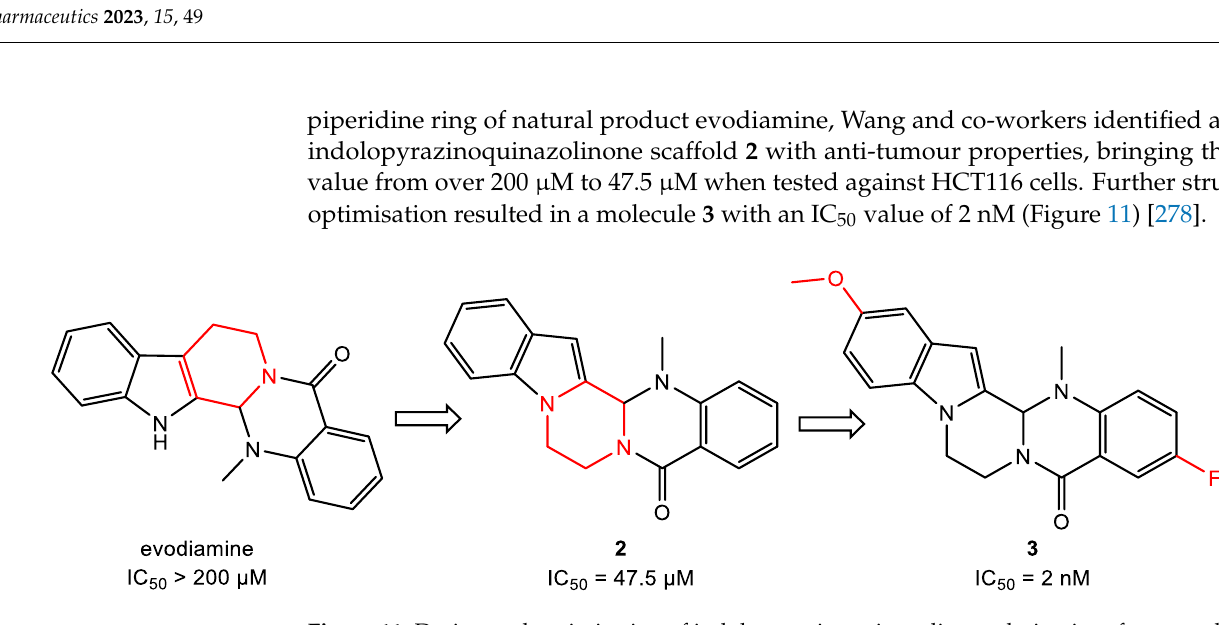
Figure 11. Design and optimisation of indolopyrazinoquinazolinone derivatives from evodiamine using scaffold hopping [278].